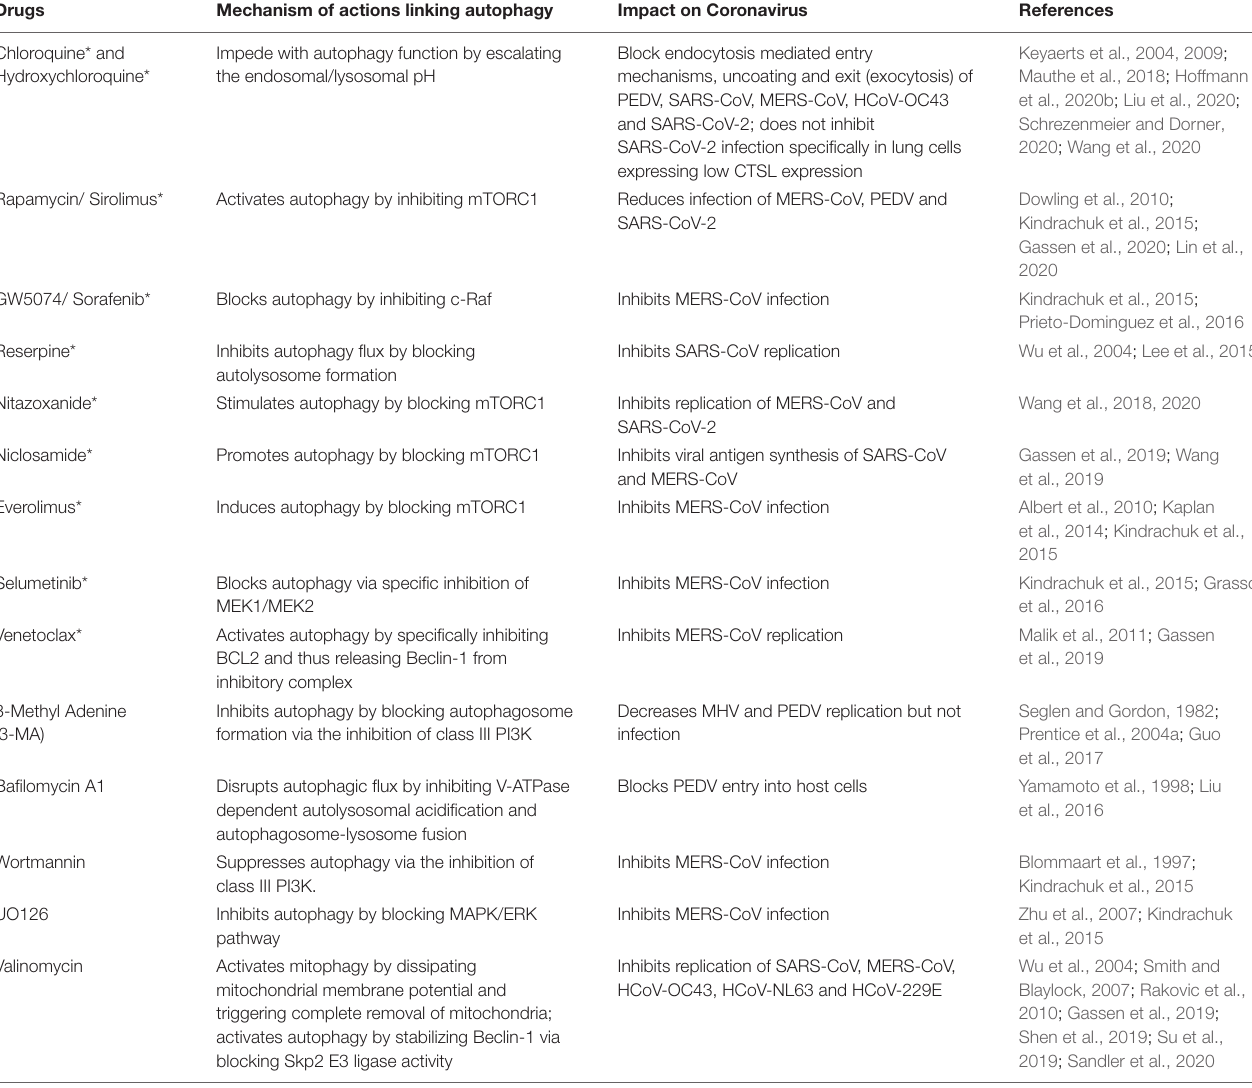
TABLE 2 | Inhibitory effects of autophagy modulators on